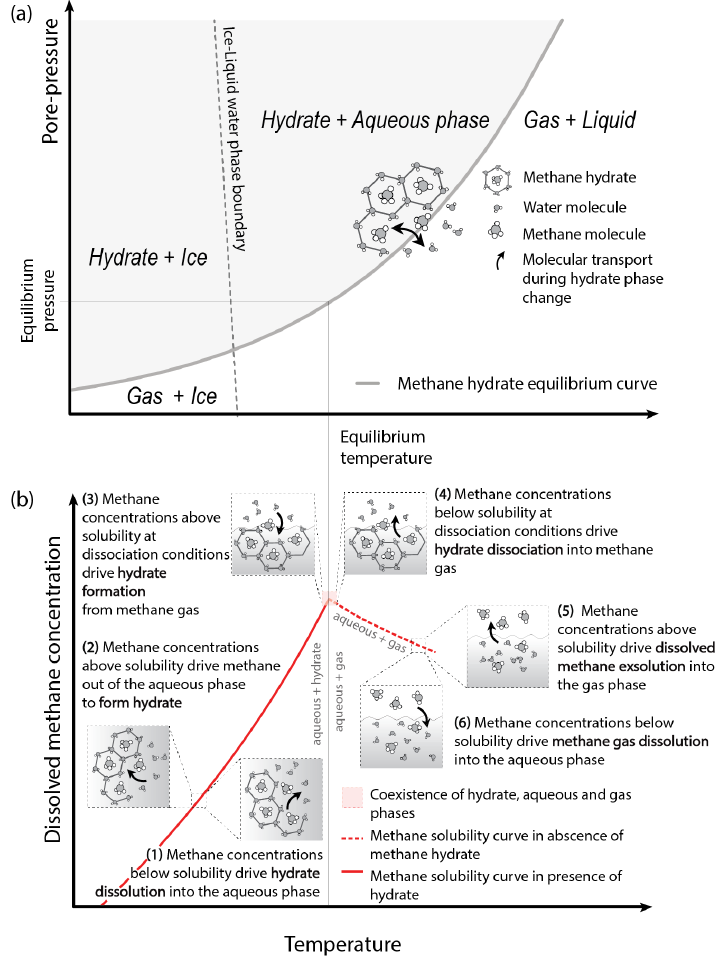
Figure 4. ( a ) Pressure-Temperature phase diagram for methane hydrate. ( b ) Methane solubility curves in the presence of hydrate (solid red curve) and without hydrate (red dashed curve) at a given arbitrary pore pressure. Depending on the system temperature, a solution with pore water under- saturated in methane will either dissolve (1) or dissociate hydrate (4) until the methane concentration in the aqueous phase reaches the equilibrium value. Note that methane solubility decreases with decreasing temperature in the presence of hydrate. Modified from